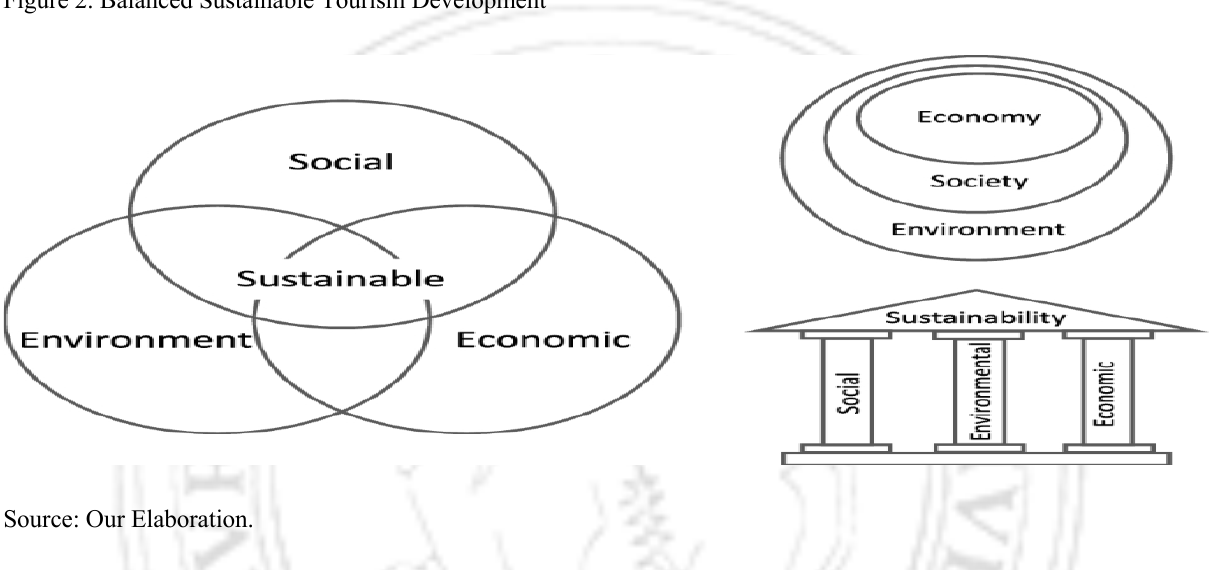
Figure 2. Balanced Sustainable Tourism Development